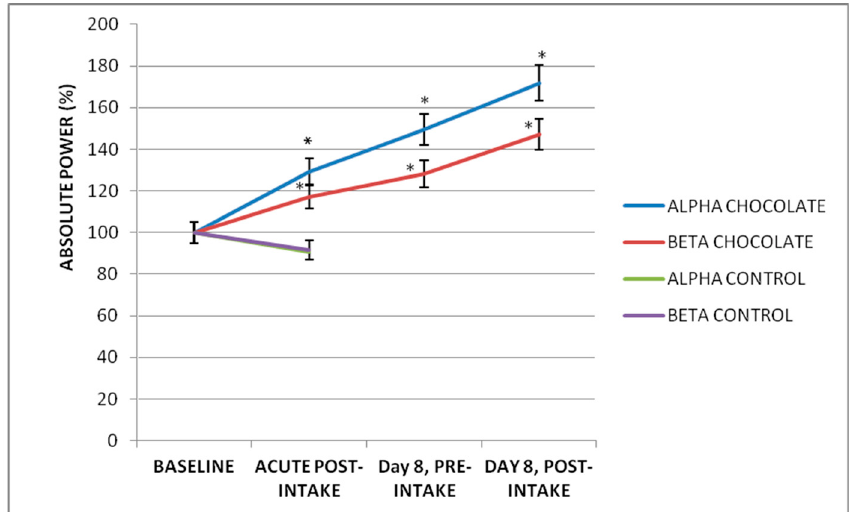
Figure 4. Effects of dark chocolate intake on the EEG bands in the O2-AVR lead. An increase of the Alpha and Beta AP was observed after the ingestion of a dark chocolate, after its daily intake for seven days and finally after the last intake of it at day eight. The Alpha band showed a higher percentage of change after the dark chocolate intake (* p < 0.05, n = 20, ANOVA-test). In the control group, no significant changes were observed ( p > 0.05, n = 5, T -test).